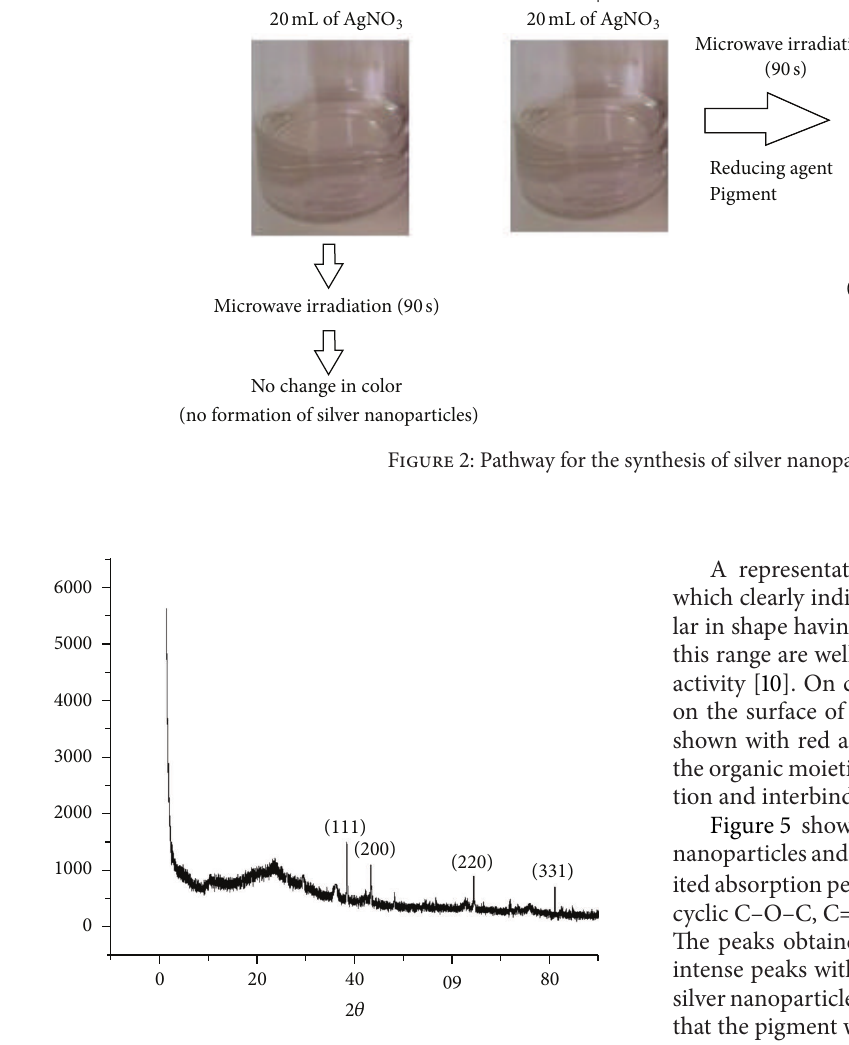
450 nm increased steadily as a function of reaction time, caused due to surface plasmon resonance of silver nanoparti- cles in the visible region [17], which clearly indicates the pre- liminary synthesis of silver nanoparticles (Figure